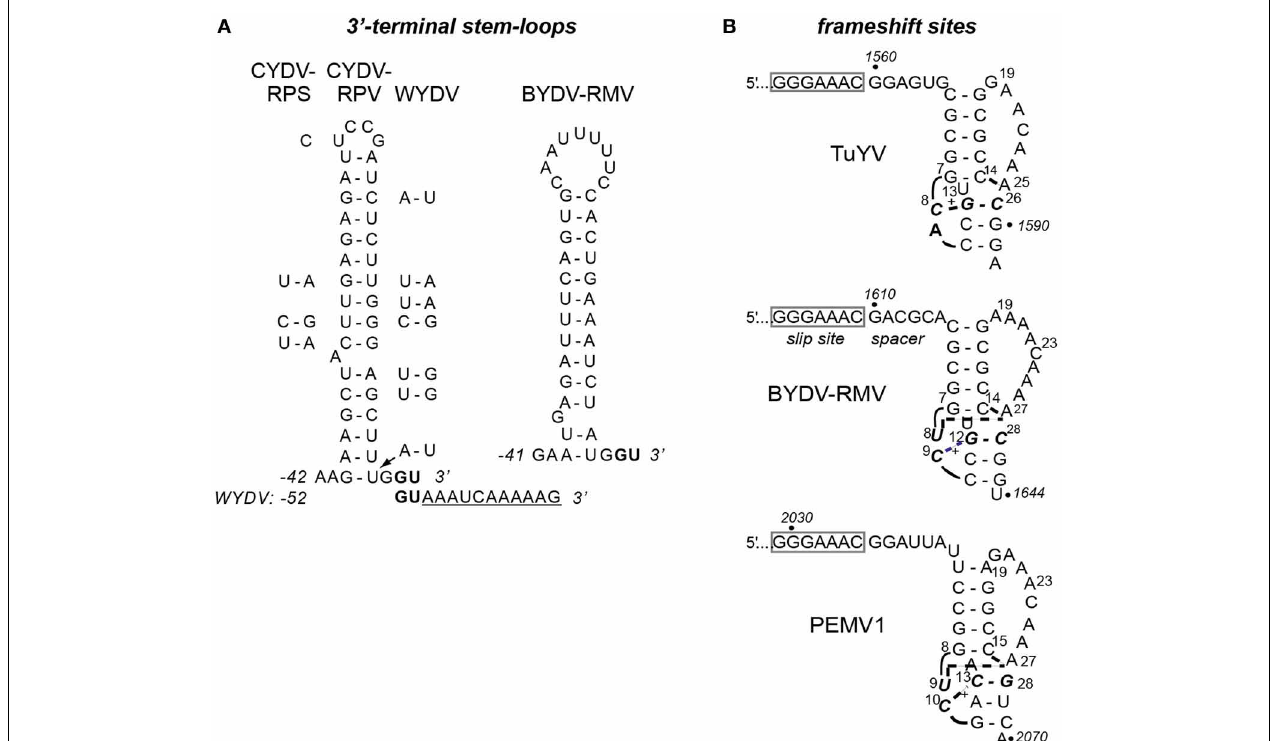
et al., 1999; Nixon et al., 2002; Miller and Giedroc, 2010) tertiary structures of pseudoknotsdownstream of the frameshift sites (boxed). Italics indicate base numbers in the genome. Other numbering is the position in the fragment used for nmr (except BYDV-RMV where the number allows comparison with the other structures). Short curved lines indicate phosphodiester backbone as necessary for two-dimensional rendering. Bold, dashed lines indicate non-Watson-Crick interactions between bases. + indicated protonated cytidine that participates in base triples. Due to the recent change of the name of the BWYV isolate used in previous structural studies (Domier, 2012) it is now indicated by the new name,